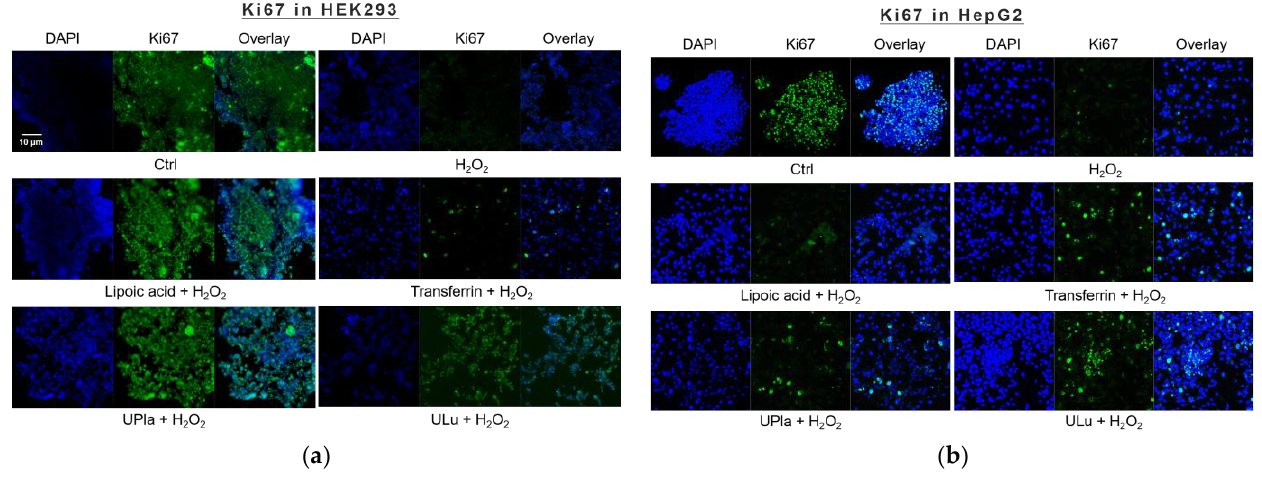
Figure 4. Cell proliferation changes in HEK293 ( a ) and HepG2 ( b ) cells upon H 2 O 2 treatment and the addition of the substances. The blue color shows DAPI-stained cell nuclei; the green represents Ki67 antibody staining. ( a ) Cell proliferation was decreased due to H 2 O 2 induction, which was reversed by treatment with UPla, Ulu, and the positive control lipoic acid in HEK293 cells; ( b ) UPla, Ulu, as well as transferrin reversed the cell proliferation decline in HepG2 cells. The results are representative of three independent experiments.